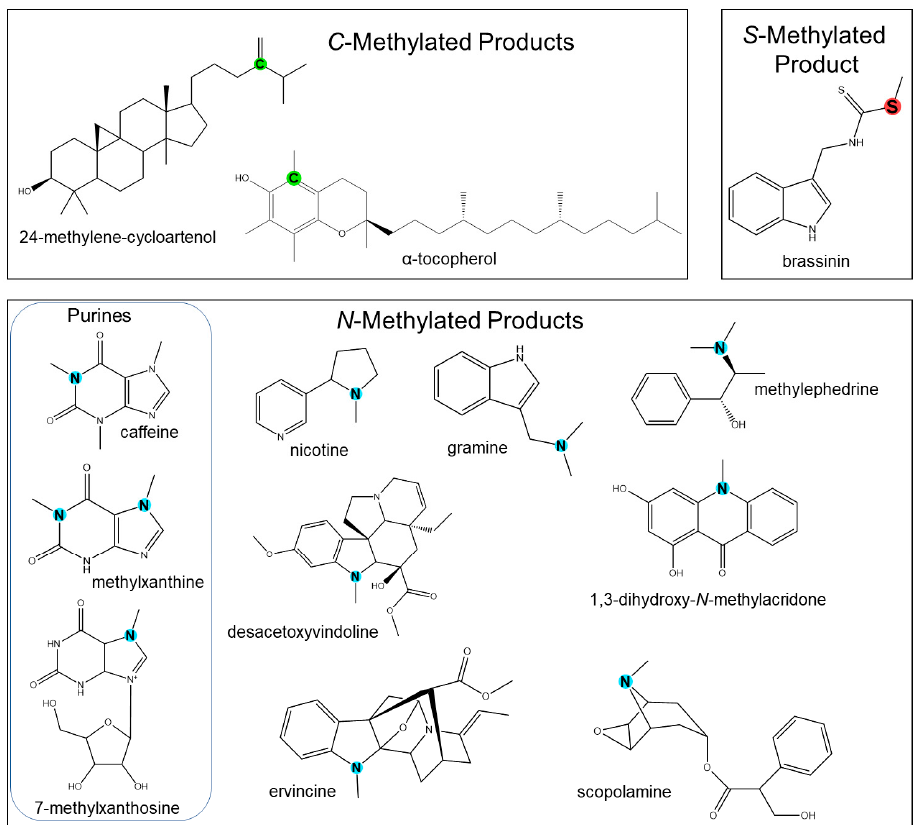
Figure 2. Representation of chemical diversity generated by N -, C -, S -directed methyltransferases. Methylated atoms are highlighted in blue ( N -), green ( C -), and red ( S -).